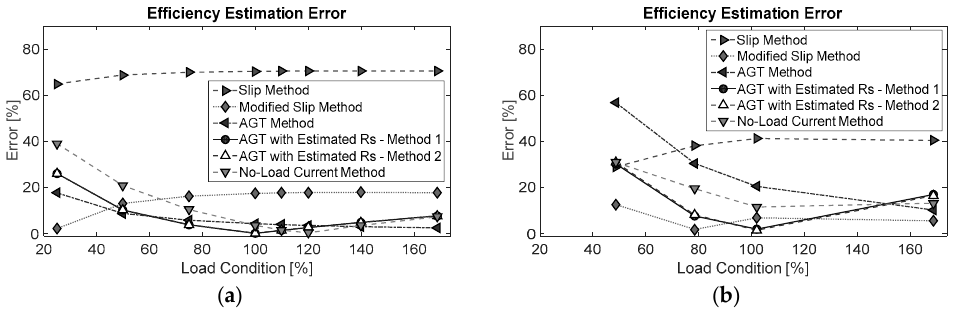
Figure 16. IM efficiency estimation error—( a ) simulation and ( b ) experimental results.